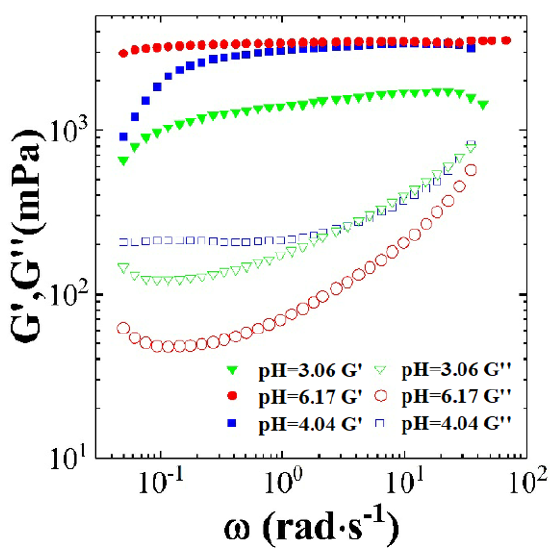
Figure 9. The dynamic rheological curves for the CTAB-CA based (30 mM CTAB + 15 mM CA) VES-fluid at pH range (3 < pH < 7) and at 25 ◦ C.